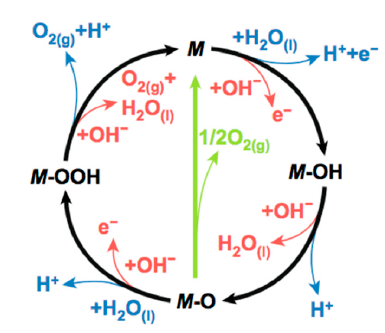
Figure 2. Simplified scheme for the oxygen evolution mechanism involving the formation of a peroxide (M–OOH) intermediate under acid (blue line) and alkaline (red line) reaction conditions. Reproduced from Ref. [87] under a Creative Commons Attribution 4.0 International License.